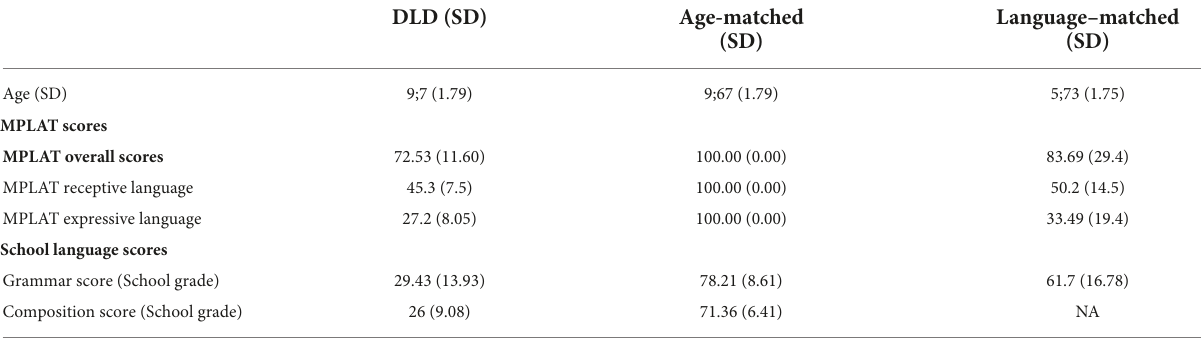
TABLE 3 Demographic details and language scores on the MPLAT components and school grades for Malay language for the three